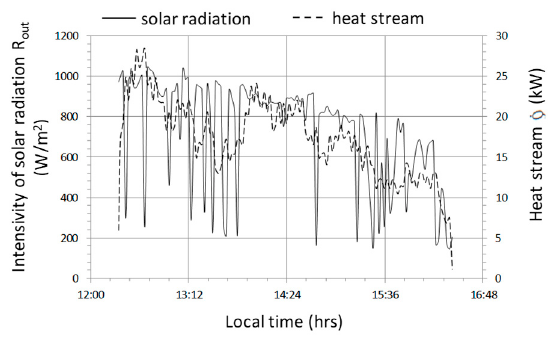
Figure 20. Timescale of solar radiation intensity and heat stream transferred to the accumulator for cycle No. 2.